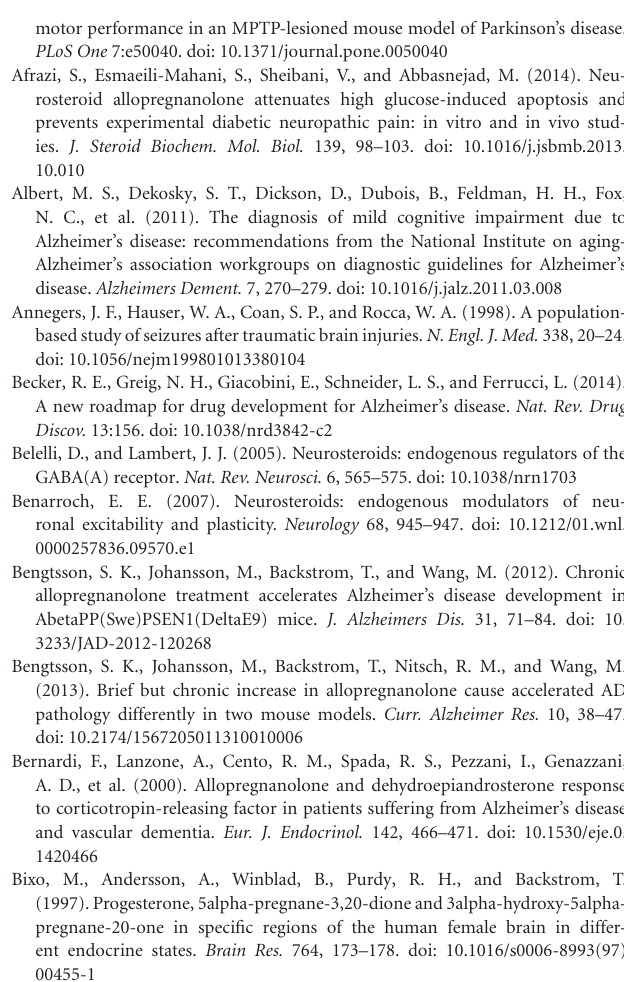
FIGURE 5 | Development of allopregnanolone for neurological disorders. Leverage points along the standard timeline of 12 years and up to 20+ years as drug development proceeds to the marketing approval target. By sharing